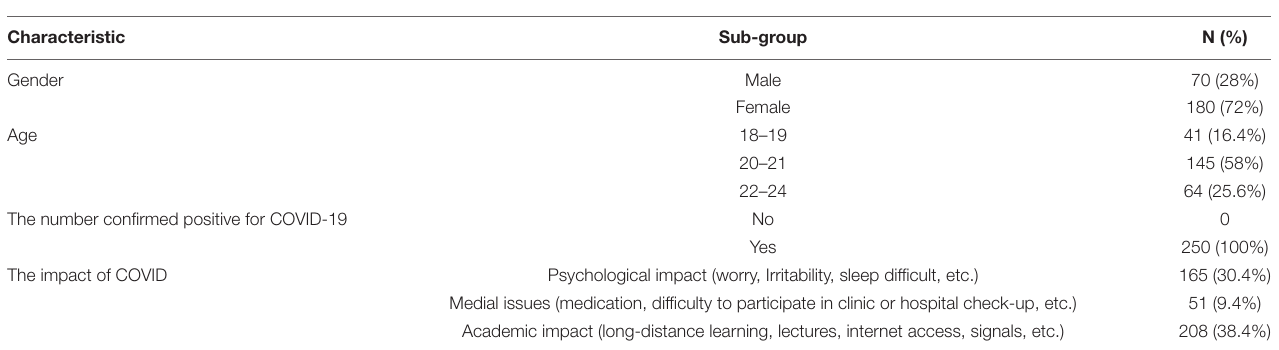
TABLE 1 | Demographic characteristic of the